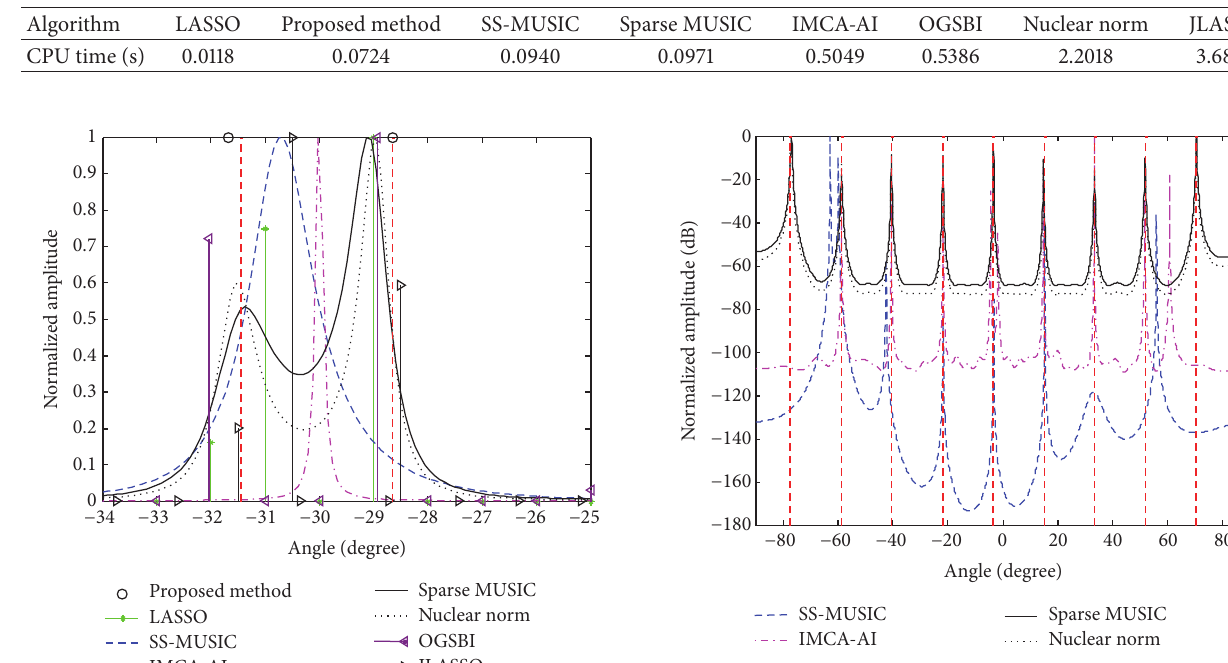
Figure 5: Spatial spectrums of MUSIC, IMCA-AI, Sparse MUSIC, and nuclear norm (𝐾 = 9) .